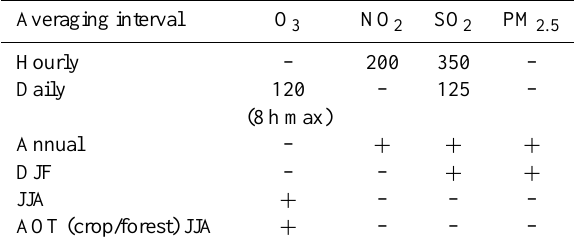
Table 4. The EC air quality standards and AOT40 (in µgm − 3 and ppbvh, respectively) for different averaging interval. ( + ): the av- erage concentration is evaluated instead of the number of the ex- ceedances. (–): no threshold value defined.